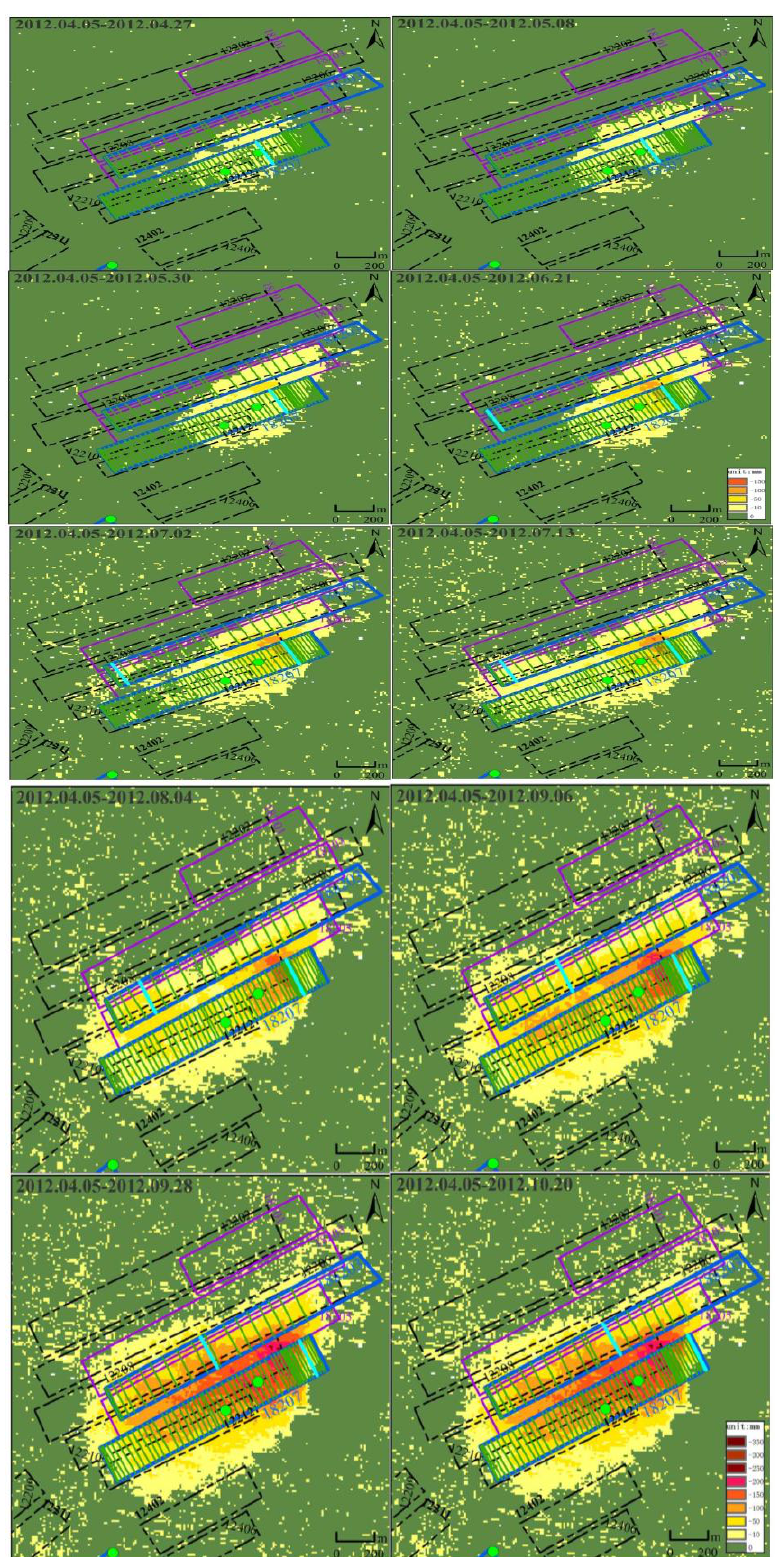
Figure 9. Time ordered subsidence maps around 18207 working face. Green points are corner reflectors and Green lines are progress lines. The unit of subsidence is